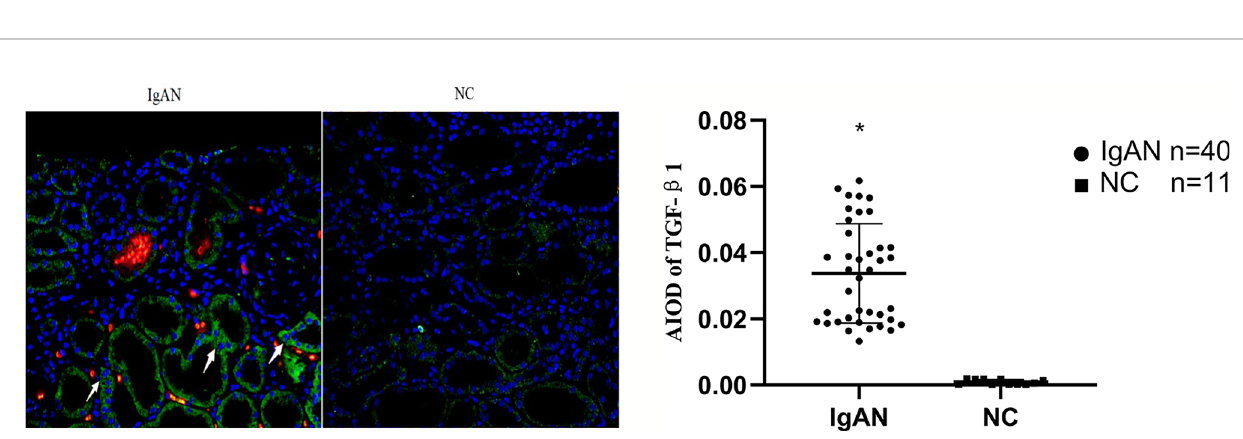
FIGURE 5 | Expression of TGF- b 1 in two groups. TGF- b 1 expressed mainly in renal tubular epithelial cells and renal interstitium, but infrequent or absent in NC group. (Original magni fi cation×400); *P<0.05, IgAN vs .